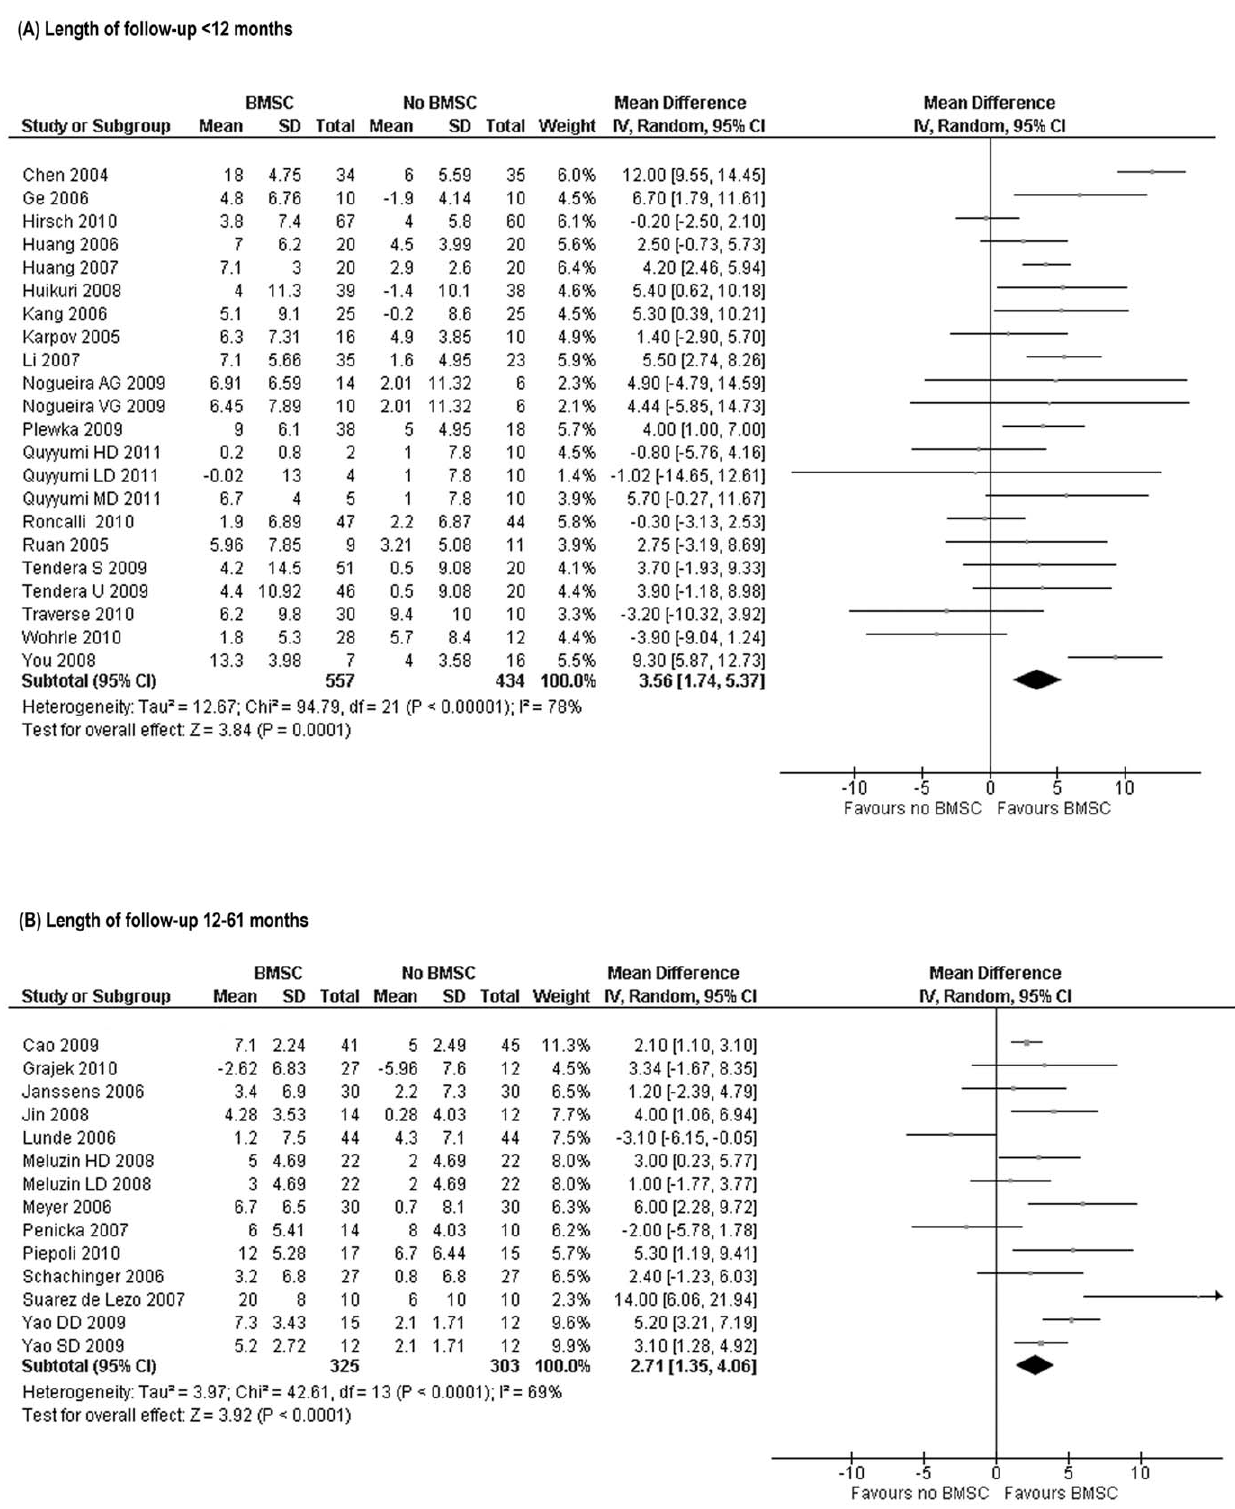
Figure 2. Forest plot of Weighted Mean Difference [WMD, with 95% CI (confidence interval)] in left ventricular ejection fraction (LVEF) in short-term follow-up. (A) Twenty-two randomised trials reporting only short-term follow-up and (B) the remaining 14 trials that reported long-term outcome data as well as short-term data. BMSC treatment significantly improved LVEF in trials with short-term follow-up (3.56%, 95% CI 1.74 to 5.37, p , 0.0001) as well as in trials with short- and long-term follow-up (2.71%, 95% CI 1.35 to 4.06, p , 0.0001).